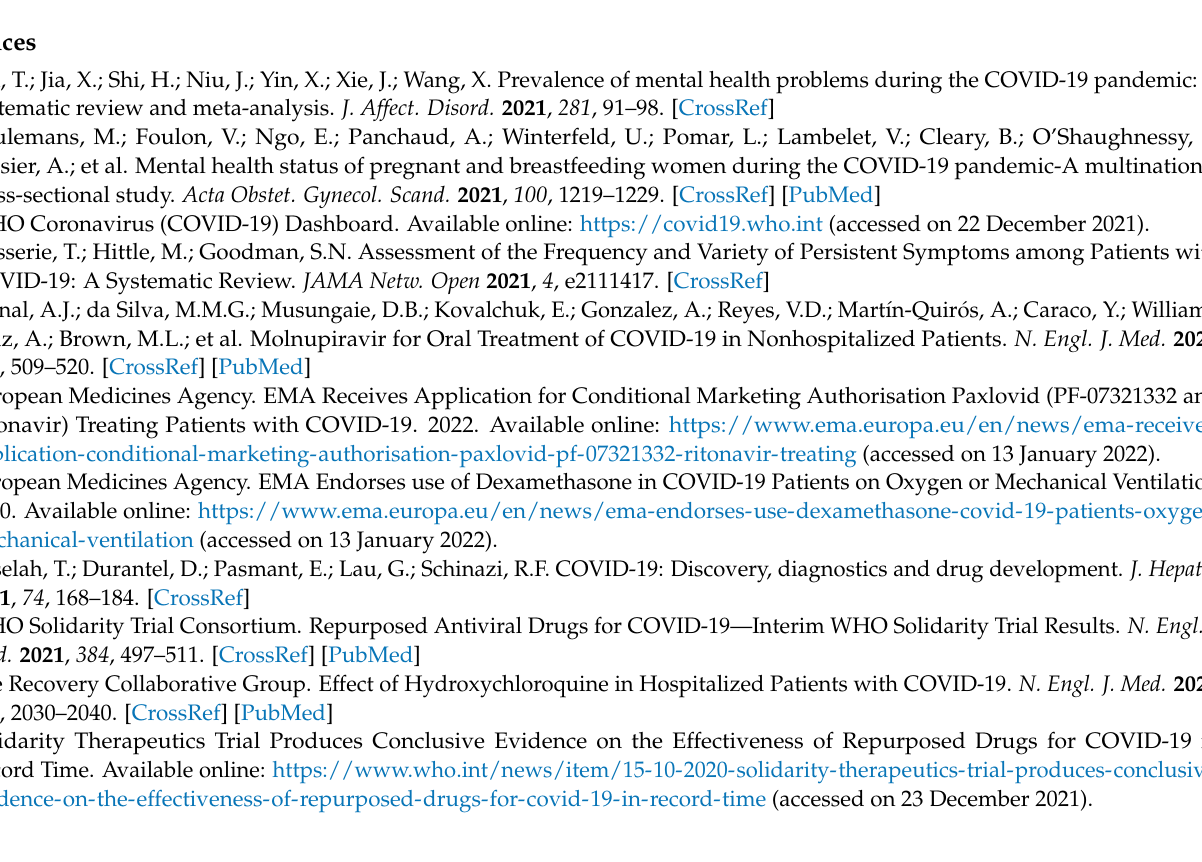
Table S5: Categorization of reasons for changing the use of a chronic medication due to COVID-19 into thematic key concepts. Supplementary Table S6: Comparison between the general birthing population and the study sample of pregnant and postpartum women for each